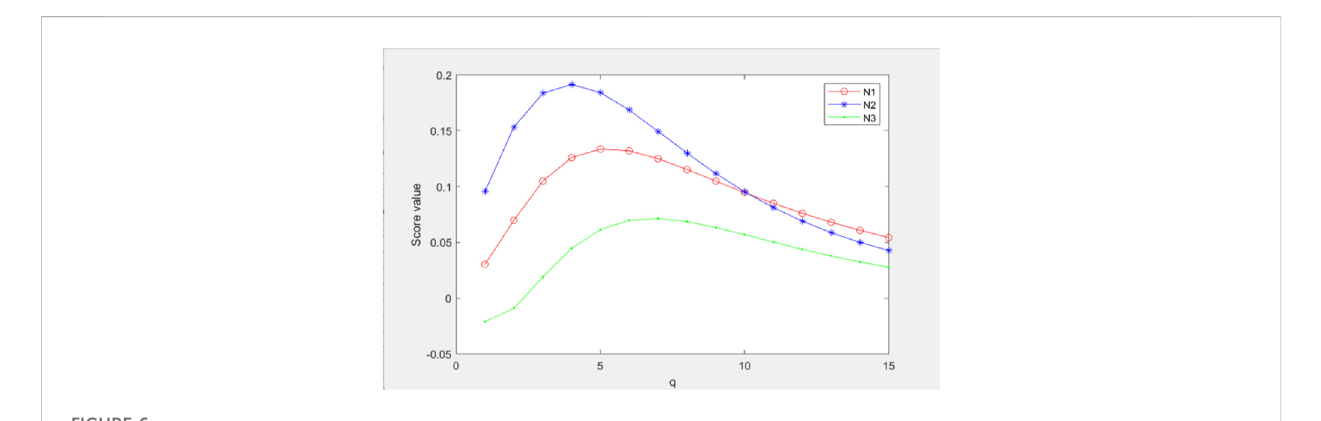
FIGURE 6 Score values of the alternatives for 1 ≤ q ≤ 15 under